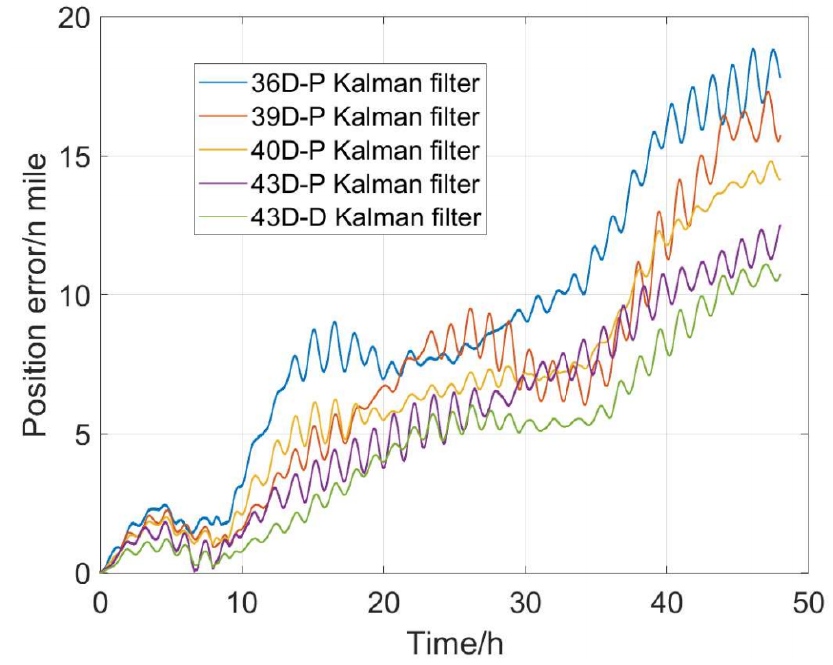
Figure 15. The positioning errors of